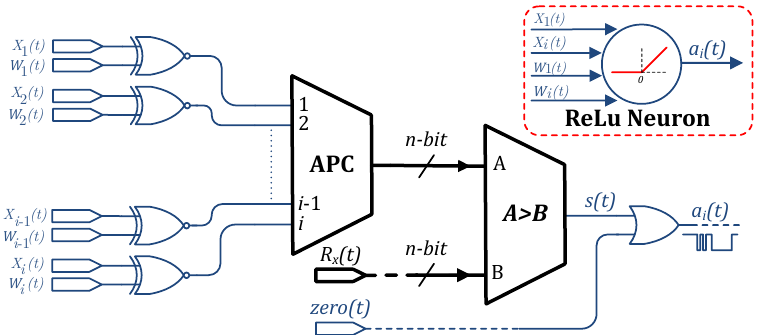
Figure 6. Stochastic neuron design exploits correlation to reduce area cost. The stochastic vectors x ( t ) and w ( t ) are uncorrelated, producing a stochastic multiplication with XNOR gates. Stochastic units are noted in blue, while the two’s complement signals are in